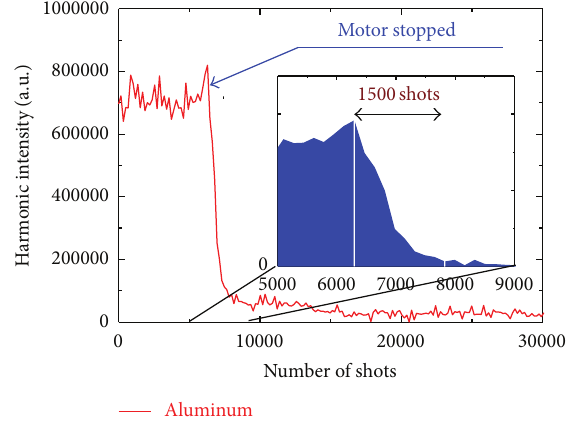
Figure 7: Decay of the harmonics from aluminum plasma after stopping the rotation of the motor. The harmonics were integrated over 40–80 nm spectral range